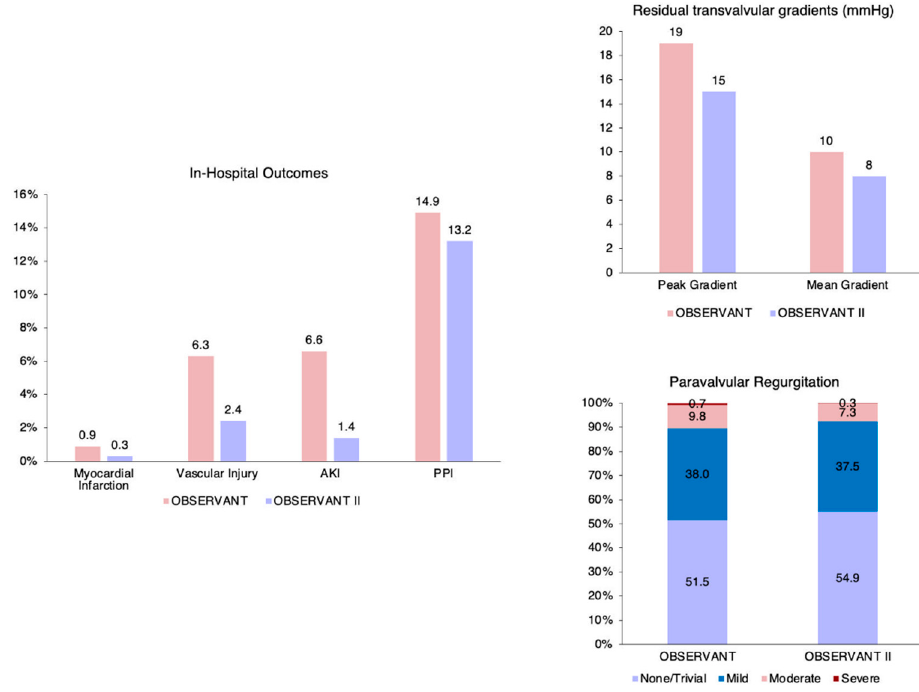
Figure 4. In-hospital clinical and echocardiographic outcomes after adjustment. AKI, acute kidney disease; PPI, permanent pacemaker implantation.